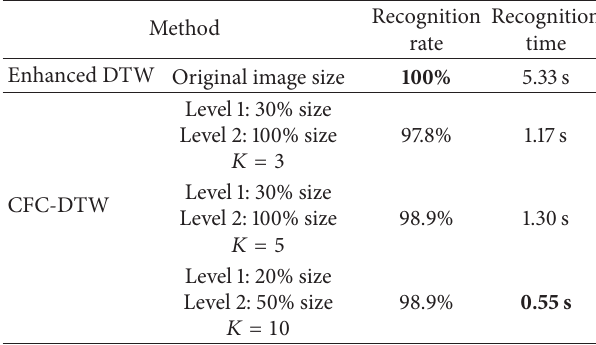
Table 1: Experiment on Weizmann